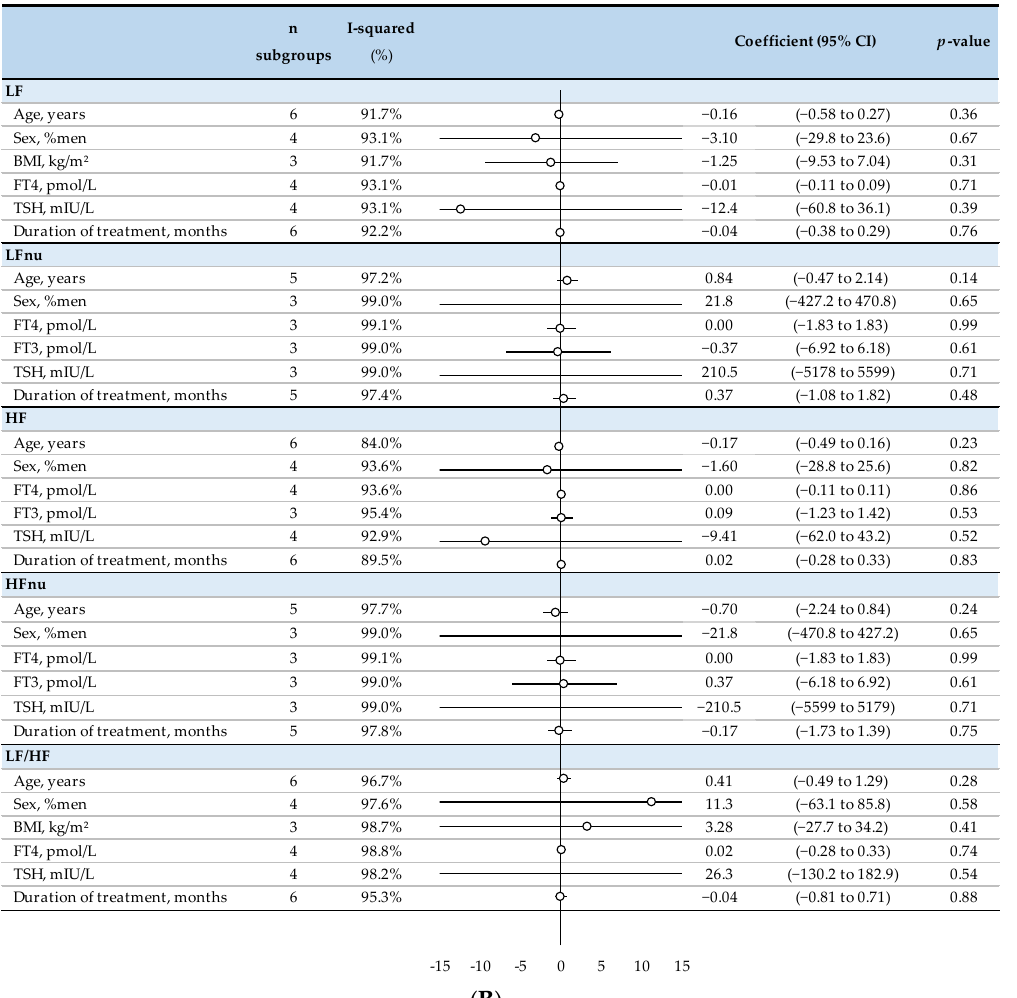
Figure 4. Metaregressions of factors influencing heart rate variability: RR, SDNN, RMSSD, pNN50, VLF, and total power in ( A ) and LF, LFnu, HF, HFnu, and LF/HF in ( B ) in treated hyperthyroid patients compared with untreated hyperthyroid patients. LF: low frequency, BMI: body mass index, FT4: free thyroxine, TSH: thyroid-stimulating hormone, LFnu: low frequency normalized—units, FT3: free triiodothyronine, HF: high frequency, HFnu: high frequency—normalized units, LF/HF ratio: low frequency/high frequency ratio. RR: RR intervals (or normal-to-normal intervals-NNs), BMI: body mass index, FT4: free thyroxine, FT3: free triiodothyronine, TSH: thyroid-stimulating hormone, SDNN: standard deviation of RR intervals, RMSSD: the square root of the mean squared difference of successive RR-intervals, SBP: systolic blood pressure, DBP: diastolic blood pressure, pNN50: percentage of adjacent NN intervals differing by more than 50 milliseconds, VLF: very low frequency. : effect size stratified by subclinical or overt